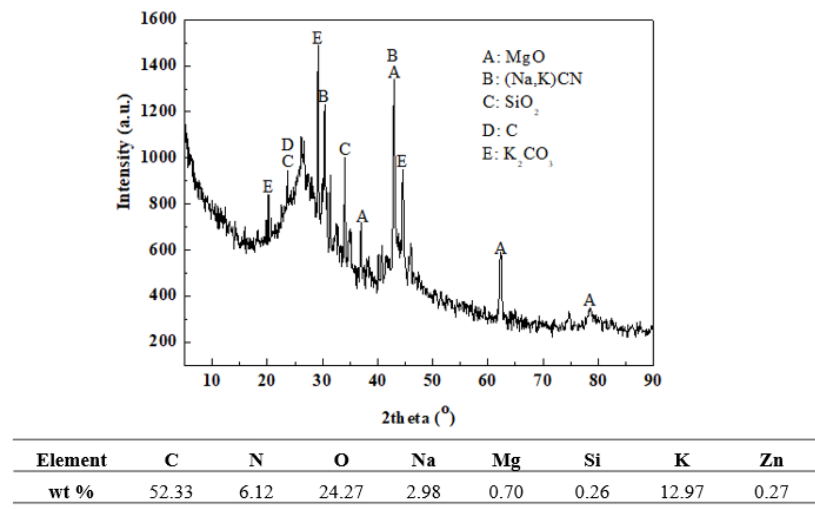
Figure 10. Analysis of Scars from the furnace.